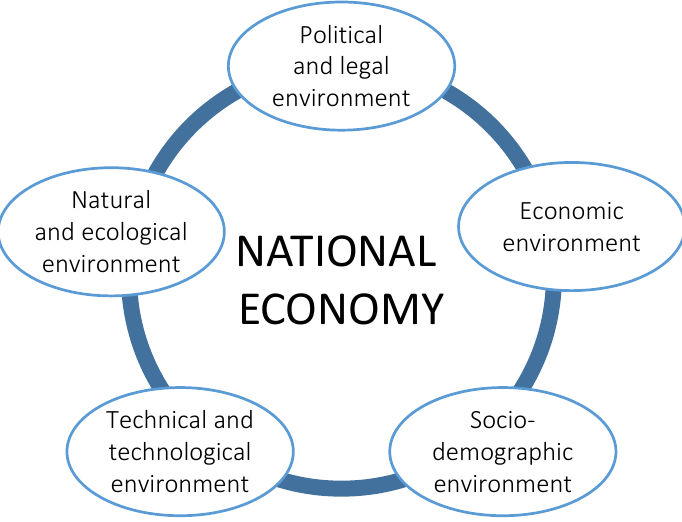
Figure 1. Scheme of influence of foreign investments on different sides of